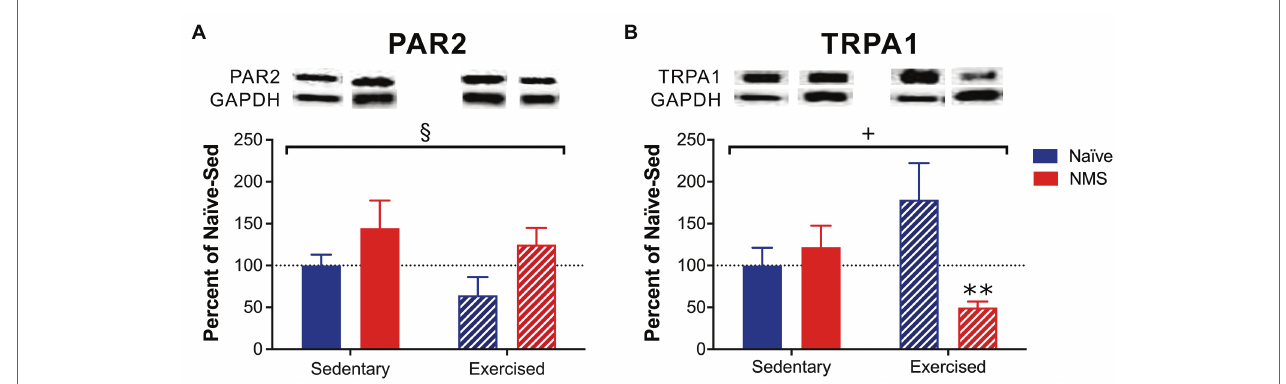
FIGURE 3 | Protein levels of protease-activated receptor 2 (PAR2) and transient receptor potential ankyrin 1 (TRPA1) were measured in the dura of Sed and Ex naïve and NMS mice using Western blot. (A) There was a significant impact of NMS on dural PAR2 protein levels. (B) A significant interaction effect of NMS and